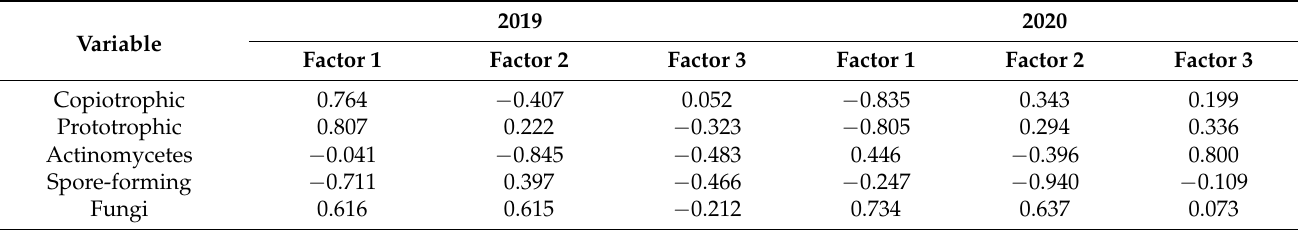
Table 9. The correlations between principal components from microbial community analysis and soil structural characteristics. Variable